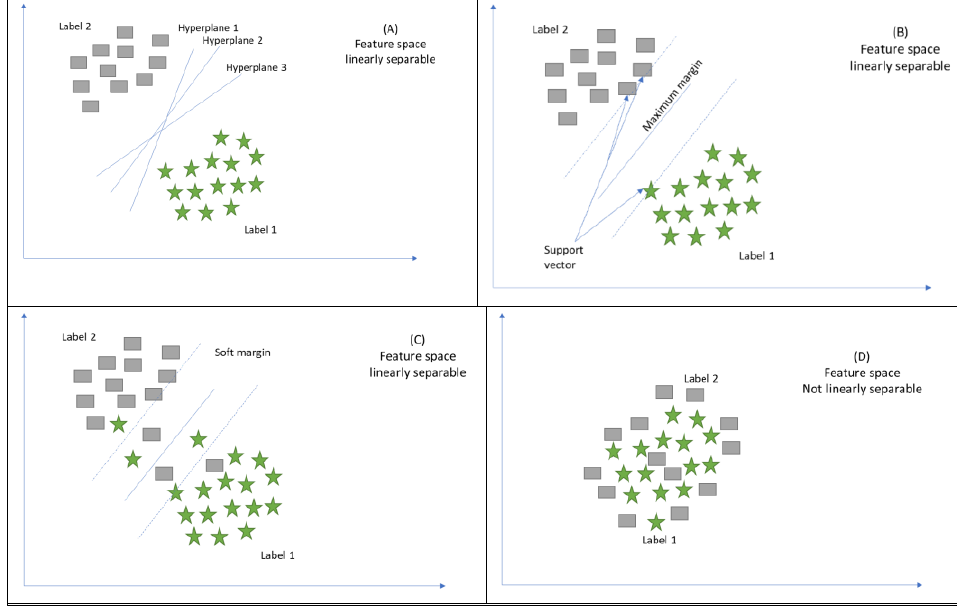
Figure 6. Classification scenario using a simple SVM algorithm.